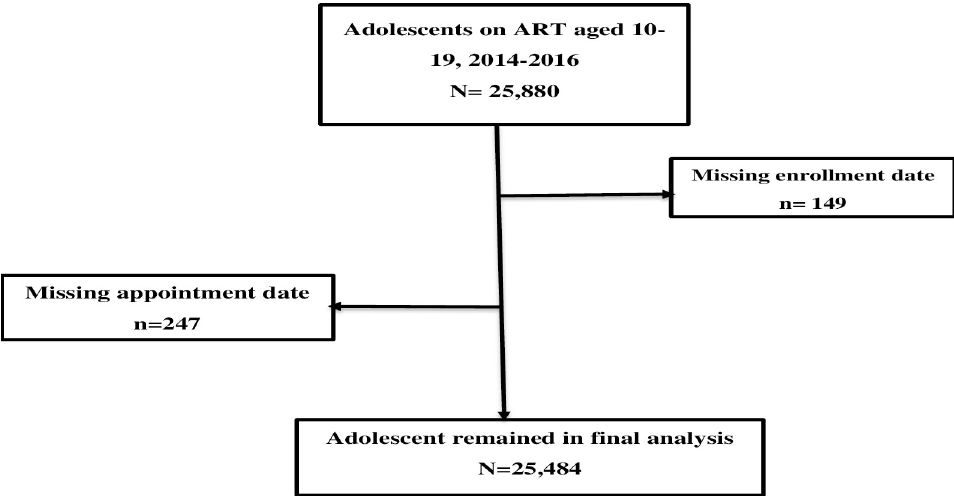
Fig 1. Flow chart for the selection procedure of the study